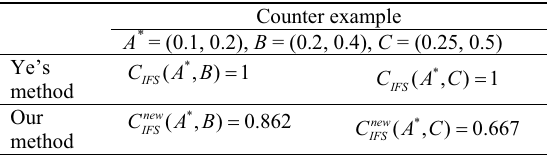
Table 2. A comparison between Ye’s method and our method in the counter example. Counter